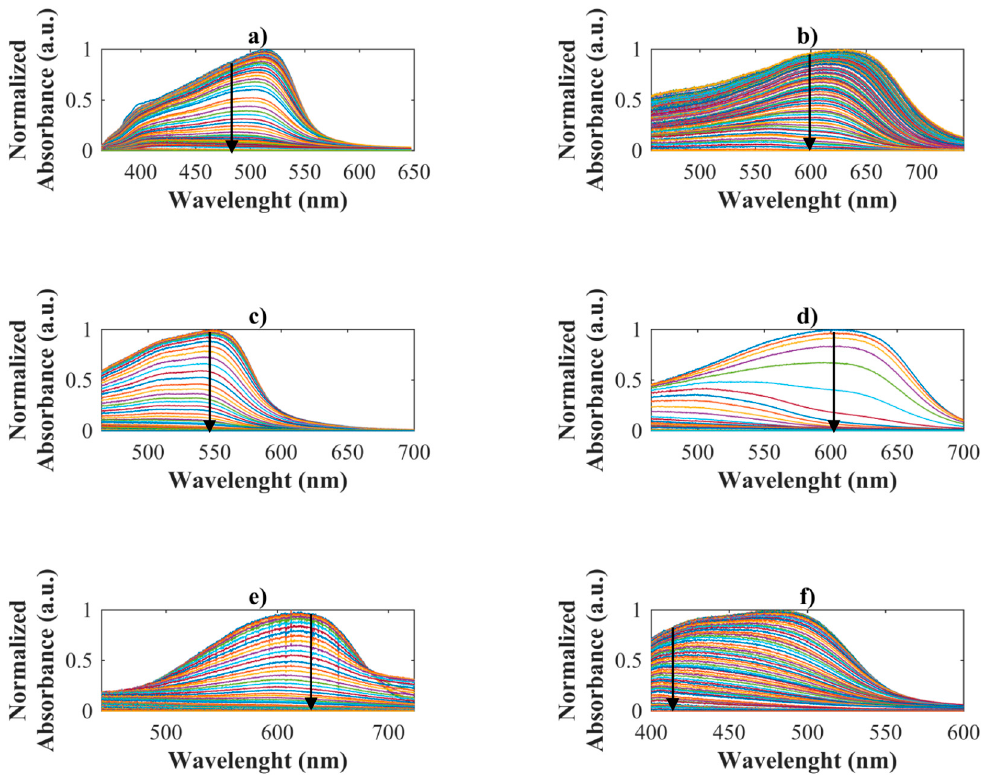
Figure 4. Absorbance of each dye. ( a ) OP2, ( b ) RB, ( c ) PC, ( d ) PN, ( e ) PB, ( f ) PY.